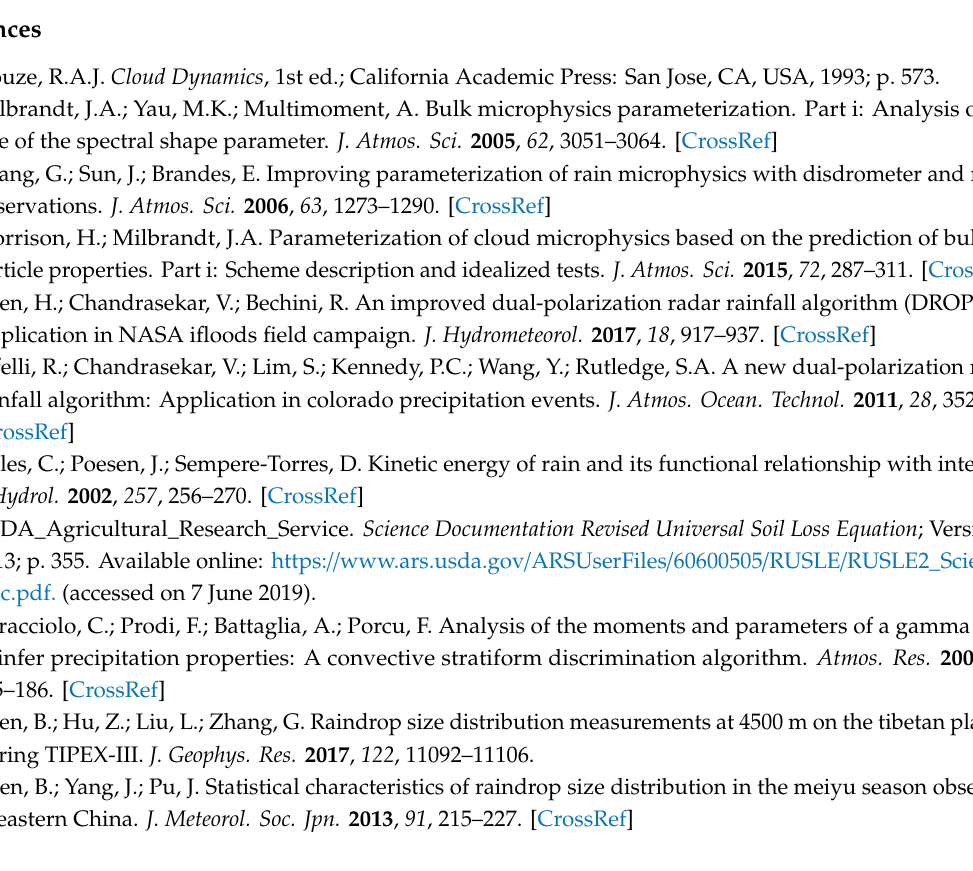
Figure S2. As in Figure 4, but for BR03 classification scheme. Figure A2. As in Figure 4, but for BR03 classification